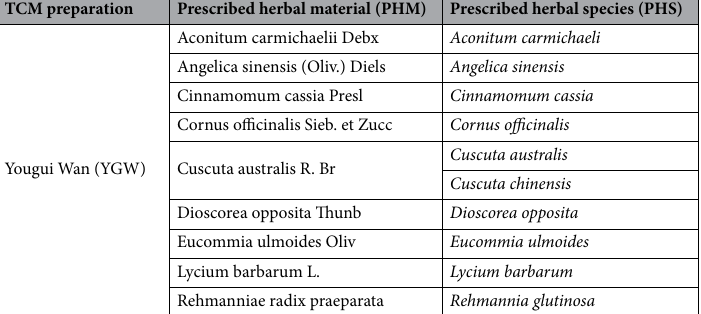
Table 2. The abbreviation of prescribed herbal materials and their corresponding prescribed herbal species of Yougui Wan (YGW) recorded in the Chinese pharmacopoeia. Un-prescribed herbal materials mainly include the substituted herbal species (SHS) and contaminated herbal species